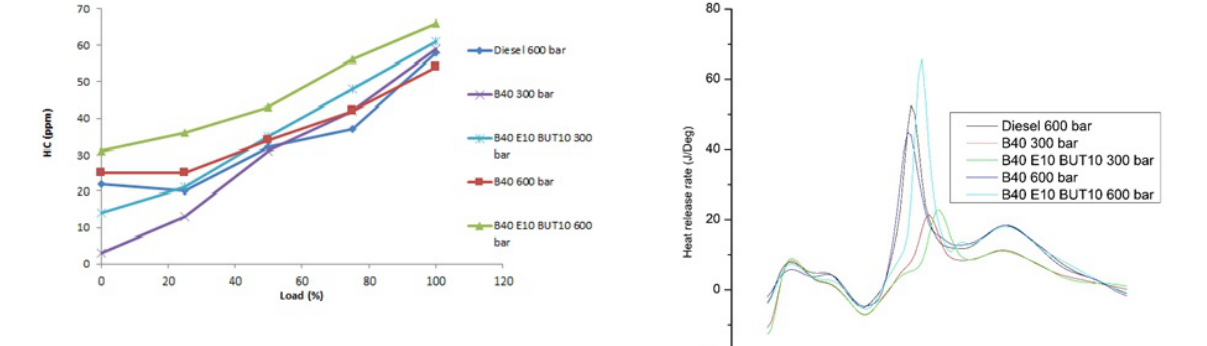
Fig. 6. Various Hydrocarbon with Engine Load.